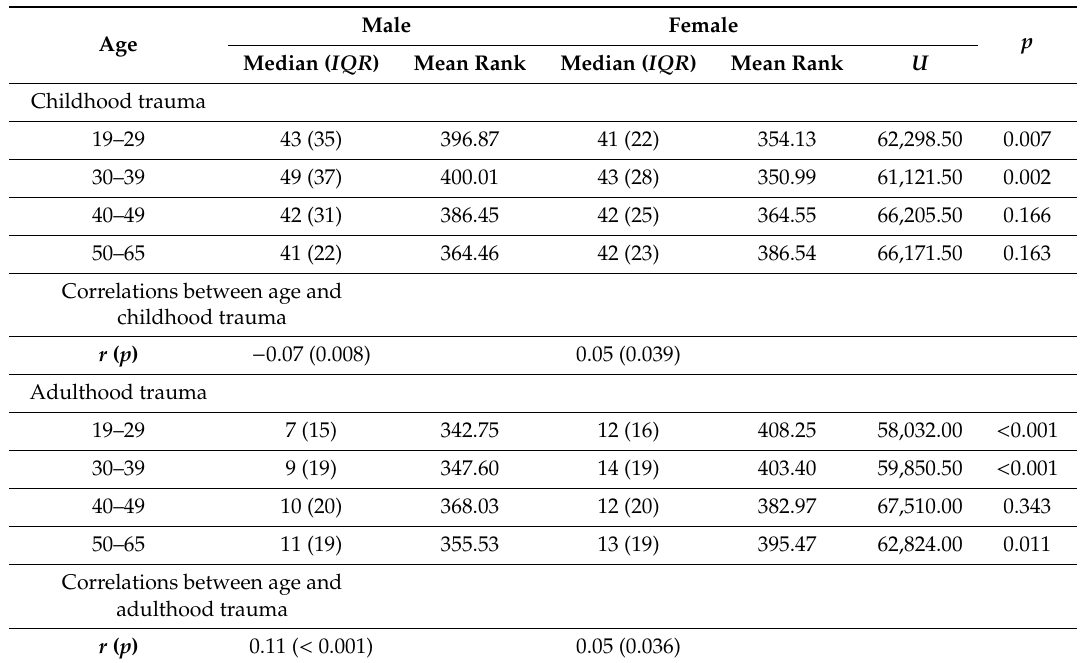
Table 3. Di ff erences in childhood and adulthood trauma by gender and